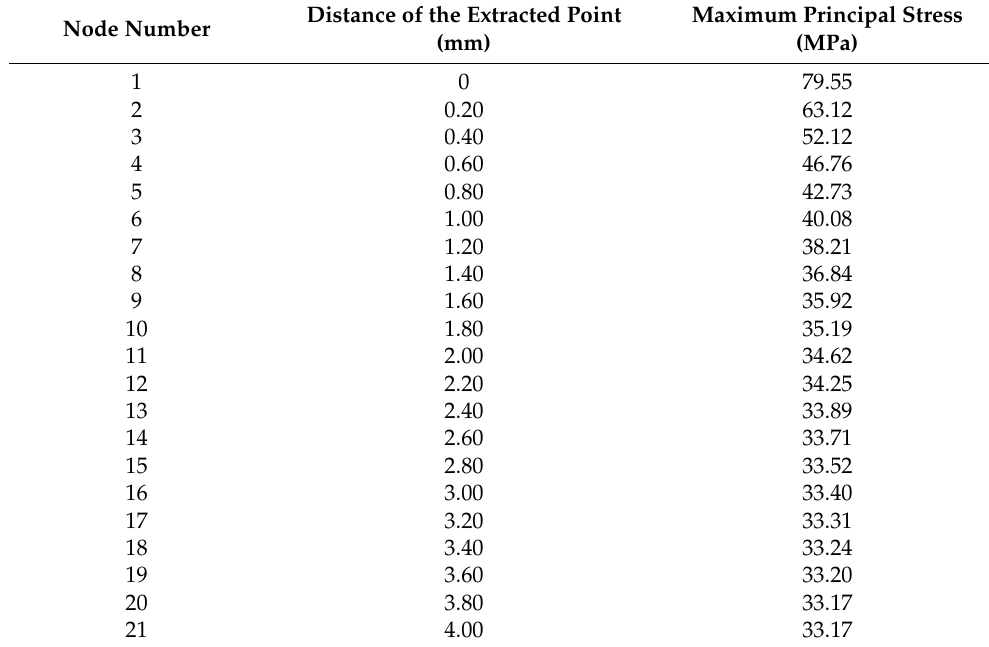
Table 3. Stress distribution of the specified